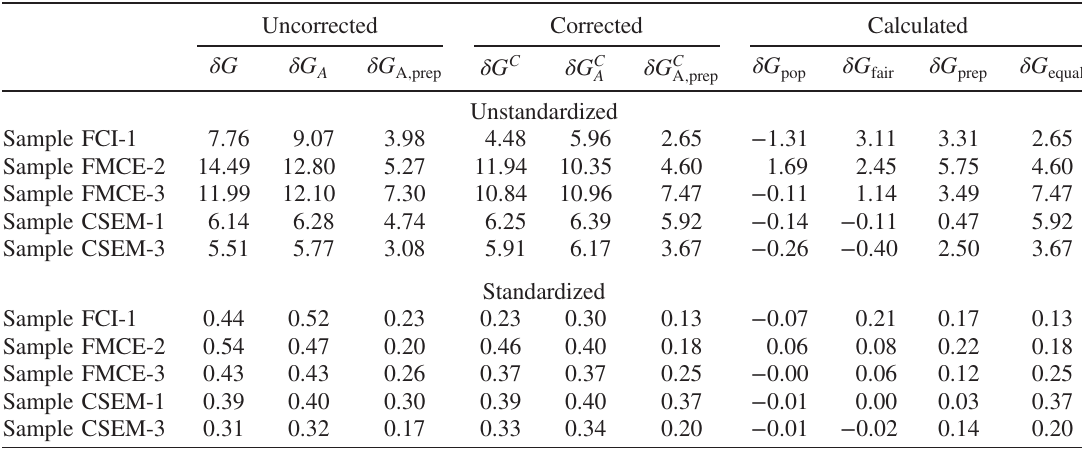
TABLE VI. Decomposition of the gender gap. Presents a partitioning of the gender gap. All unstandardized values are